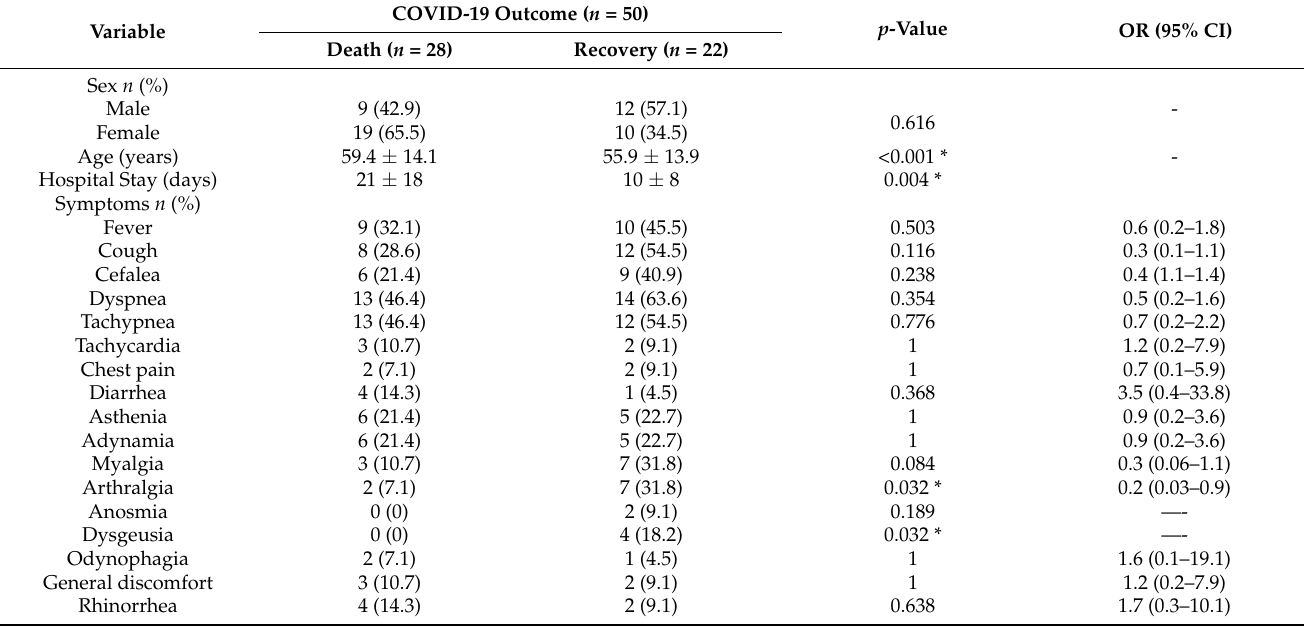
Table 1. General characteristics of hospitalized patients with COVID-19 included in the study.